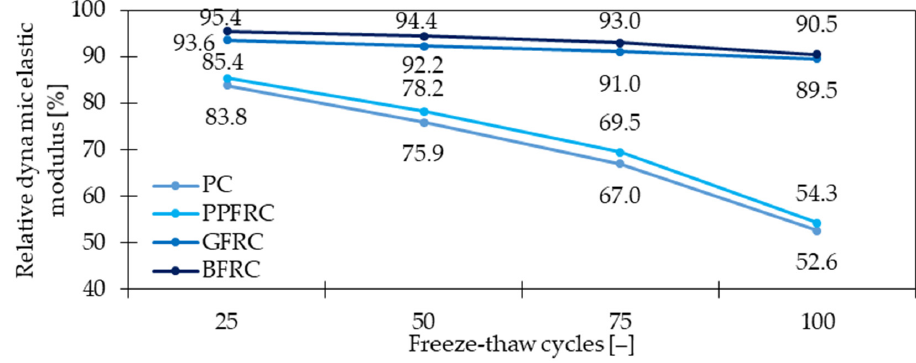
Figure 26. Relative dynamic elastic modulus for different FRC subjected to freeze-thaw cycles [115].